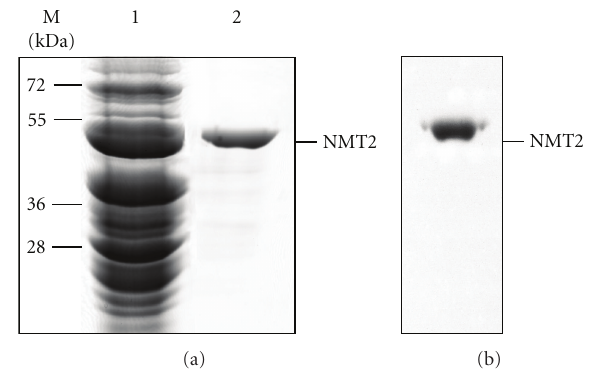
Figure 3: SDS-PAGE and Western blot analysis of bovine brain NMT2. Thirty microgram of proteins was loaded onto (a) SDS- PAGE; lane 1, crude cell lysate; lane 2, purified E. coli expressed bovine brain NMT2. (b) Purified E. coli expressed bovine brain NMT2 (thirty microgram) immunoblotted with monoclonal anti- NMT2 (1:1000 dilution) as described in Section